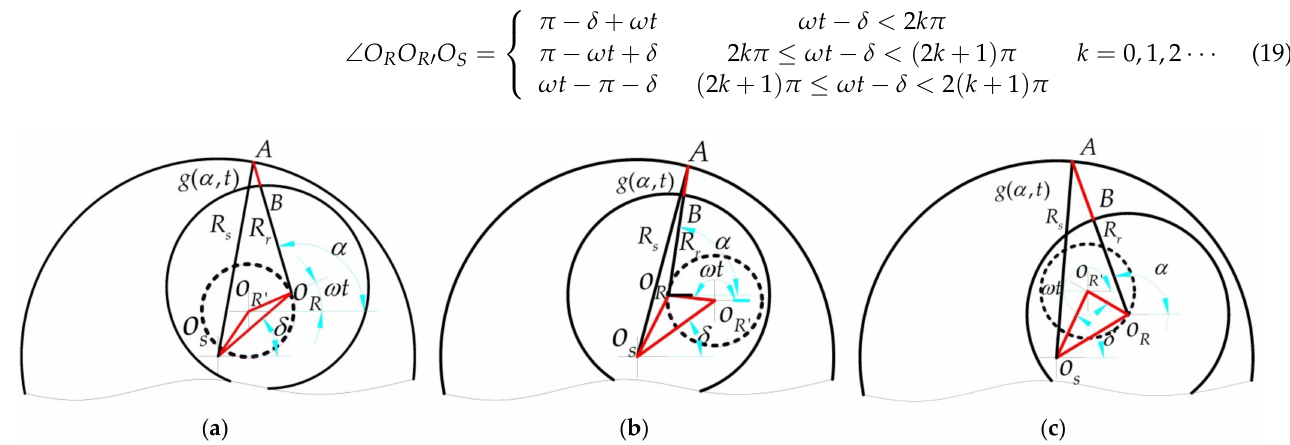
Figure 2. The geometric model of the air-gap with mixed eccentricity. ( a ) ω t − δ < 2 k π ; ( b ) 2 k π ≤ ω t − δ < ( 2 k + 1 ) π ; ( c ) ( 2 k + 1 ) π ≤ ω t − δ < 2 ( k + 1 ) π